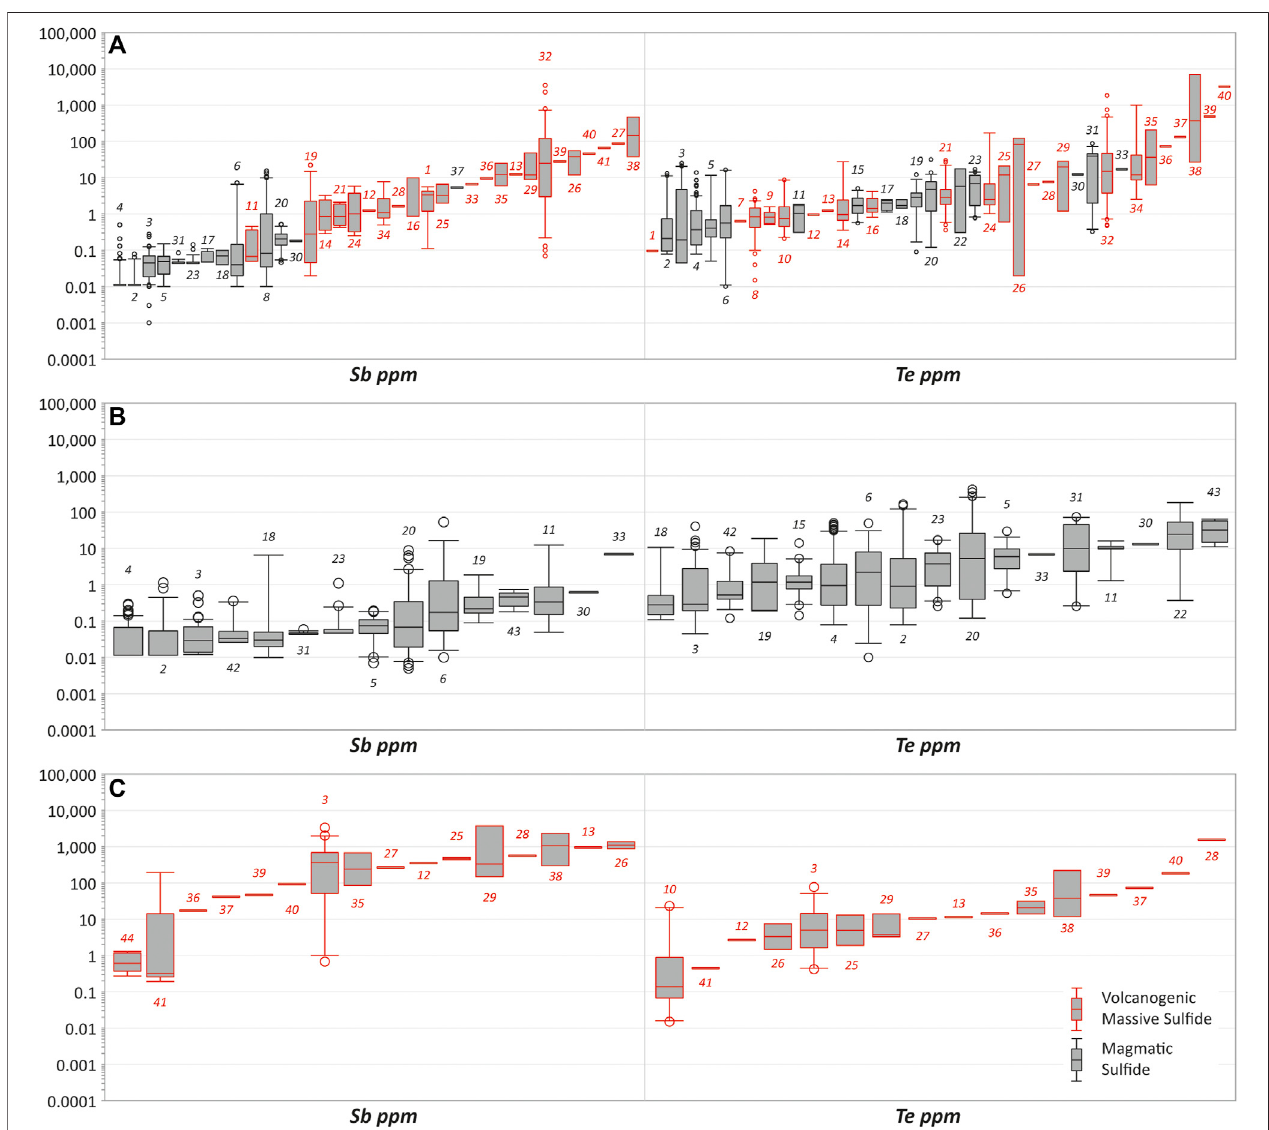
FIGURE2| SummaryofSbandTetraceelementconcentrationsinoresul fi desfromcompiledLA-ICP-MSanalysesofmagmaticsul fi de(N=18)andvolcanogenic massivesul fi de(N=26)deposits( SupplementaryTableS1 ). (A) Chalcopyrite. (B) Pentlandite. (C) Sphalerite.AlthoughSb,Bi,Cd,Co,In,SeandTewereinvestigated inthisstudyhereweonlyshowSbandTeasanexampletosavespace.MineralDeposits1,Vorta;2,StillwaterComplex;3,LacdesIlesComplex;4,BushveldComplex; 5, Mirabela Complex; 6, Great Dyke; 7, Mala; 8, Sulitjelma; 9, Phoenix; 10, Bieluwutu; 11, Alexo; 12, Tash-Tau; 13, Talgan; 14, Kokkinoyla; 15, Aguablanca; 16, Three Hills; 17, Talnakh; 18, Yangliuping; 19, Duluth; 20, Sudbury Complex; 21, Apliki; 22, Jinchuan Complex; 23, Kharaelakh; 24, Phoucasa; 25, Yubileynoye;